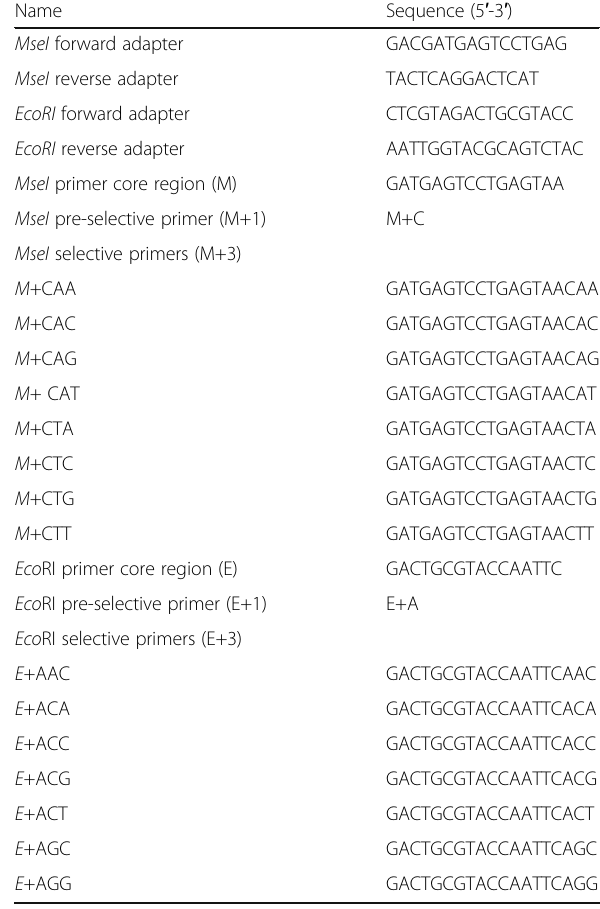
Table 1 A list of AFLP primers and adapters